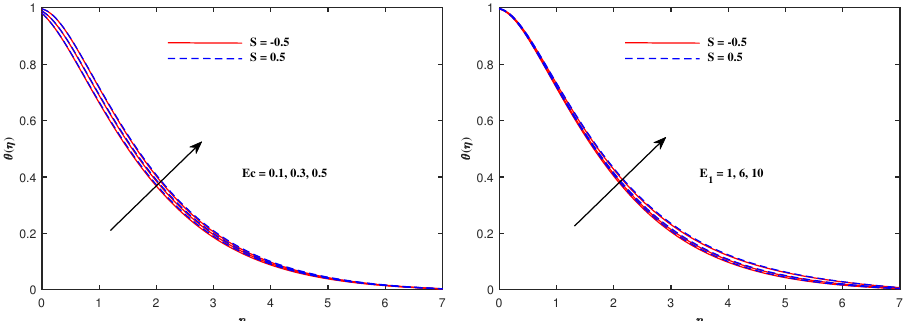
Figure 7. Temperature variation with b and Ha .